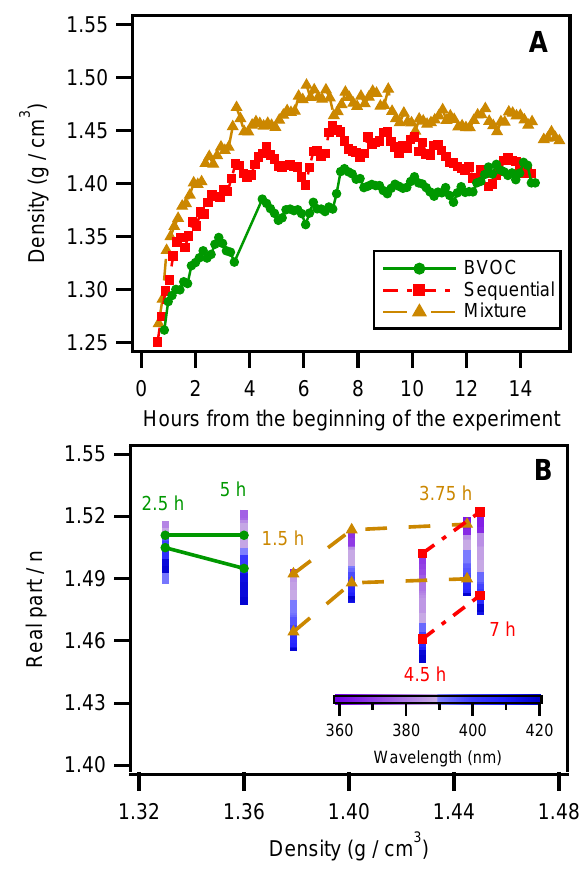
Figure 6. (A) Time series of the density measured for the BVOC (green circles), the sequential (red squares), and the mixture (orange triangles) experiment. (B) The change in time of the real part of the RI vs. density for each experiment performed. The color bars show the span in the RI for the wavelengths measured; the time span between the measurements is written above (for the BVOC and sequential experiments) and below (the mixture experiment) each set of